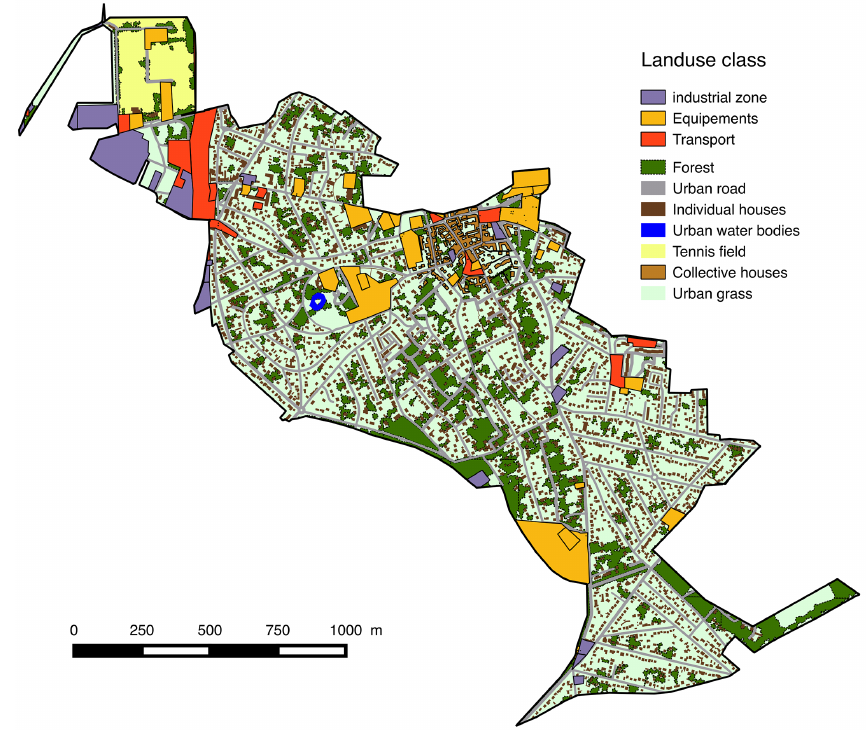
Figure 4. The land cover data available for Sucy-en-Brie catchment and used to implement the Multi-Hydro